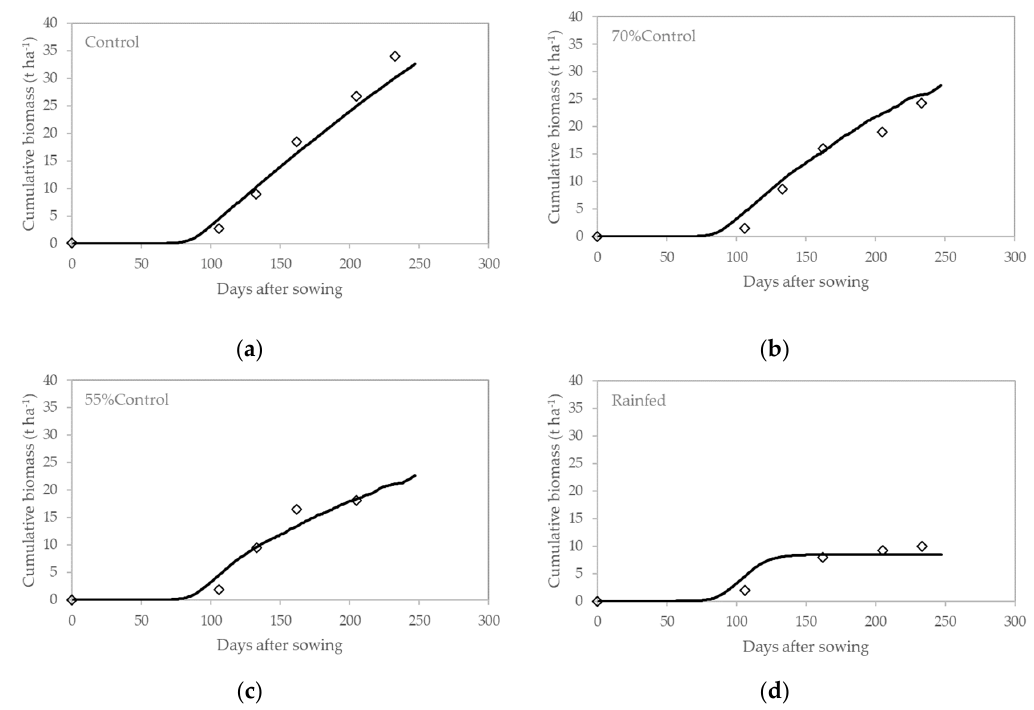
Figure 2. Observed and simulated seasonal course of biomass accumulation in dry terms for the irrigation treatments of the AIMCRA experiment used for model calibration: ( a ) control, ( b ) 70% control, ( c ) 55% control, and ( d ) rainfed. control, ( c ) 55% control, and ( d )